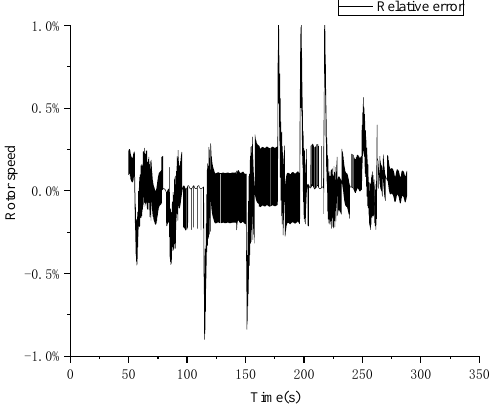
Figure 28. Relative rotor speed error between HIL and the digital simulation.